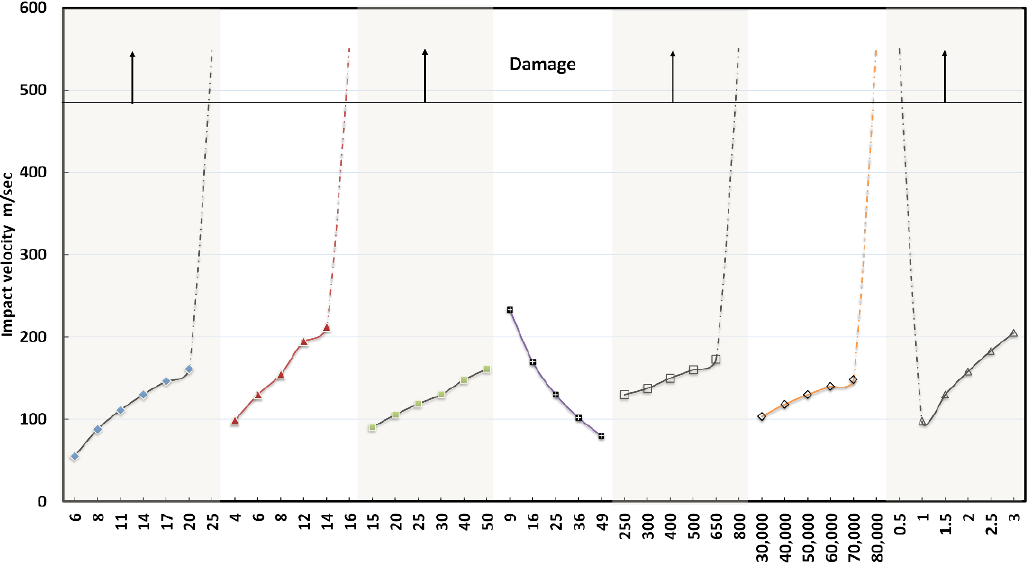
Figure 5. Process parameter selection.